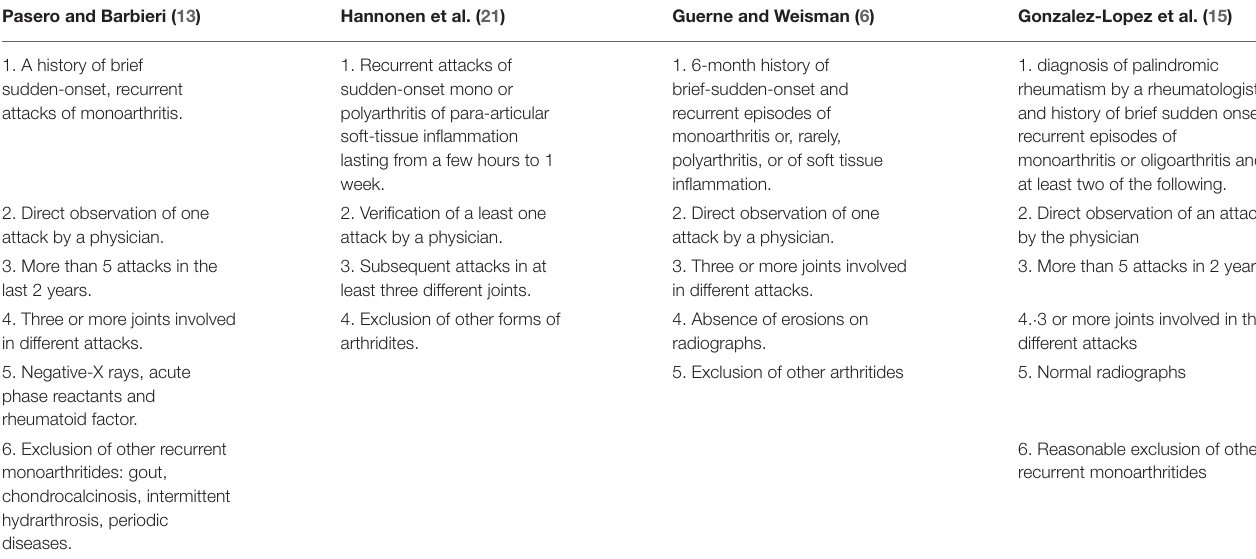
TABLE 3 | Proposed diagnostic criteria for palindromic rheumatism. Pasero and Barbieri